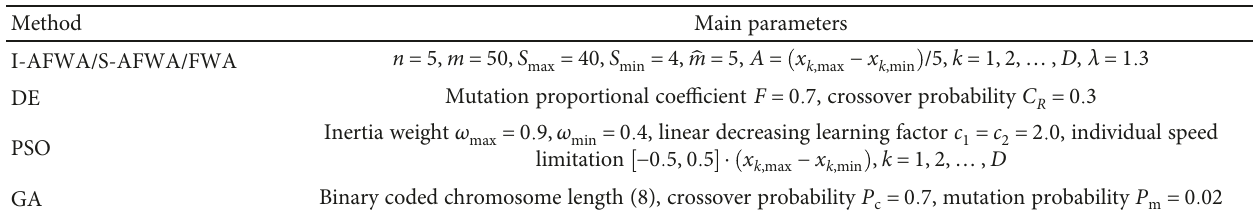
Table 1: The main parameter settings of six intelligent